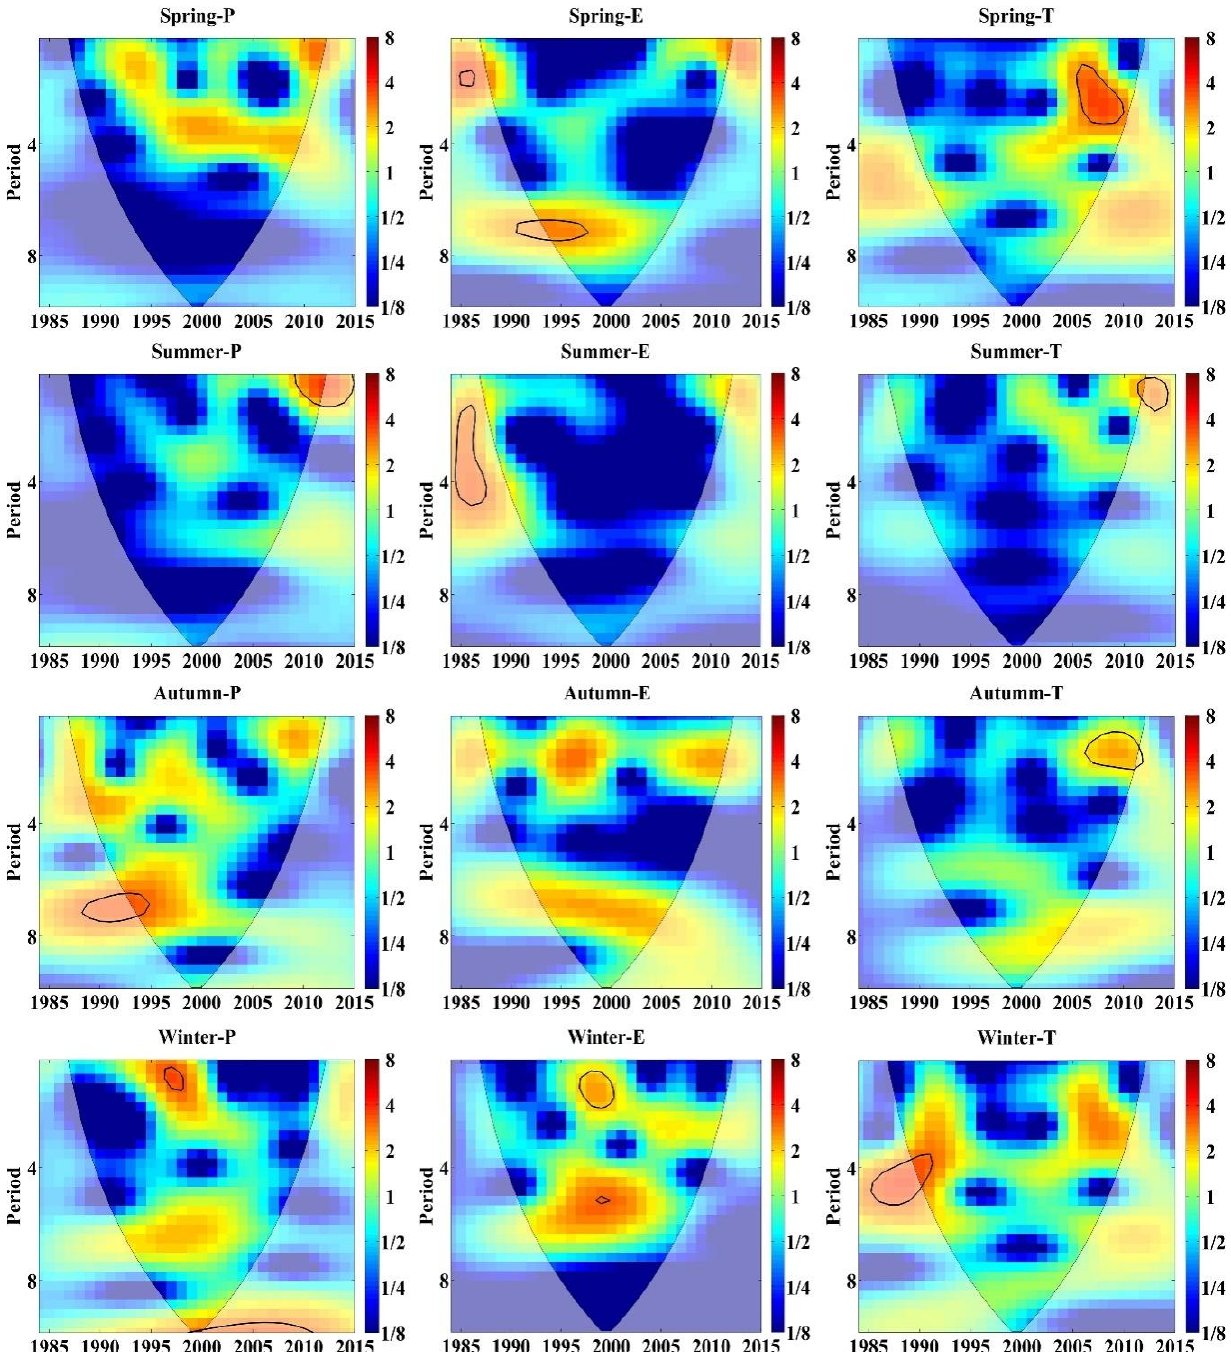
Figure 11. The continuous wavelet power spectra of seasonal rainfall, evaporation and temperature in Yinjiang River watershed. The thick black contour designates the 5% significance level against red noise and the cone of influence (COI) where edge effects might distort the picture is shown as a lighter shade.